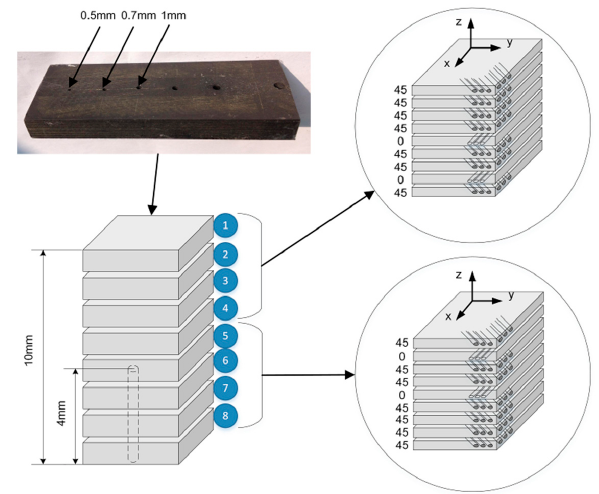
Figure 5. Lay-up of multidirectional [45 4 /0/45 2 /0/45] 4s CFRP, total thickness 10 mm.